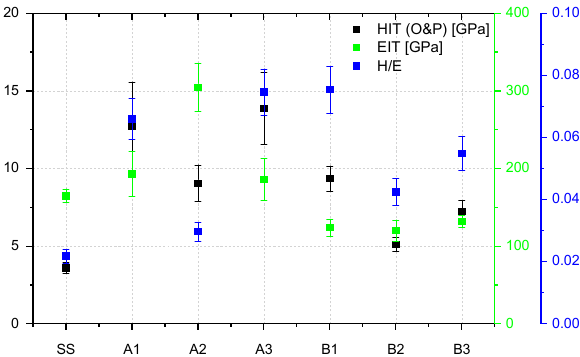
Figure 7. Indentation hardness, young modulus, and elastic strain to failure ratio determined for SiO 2 and Cr 2 O 3 investigated configurations deposited on SS substrate analyzed as a reference.